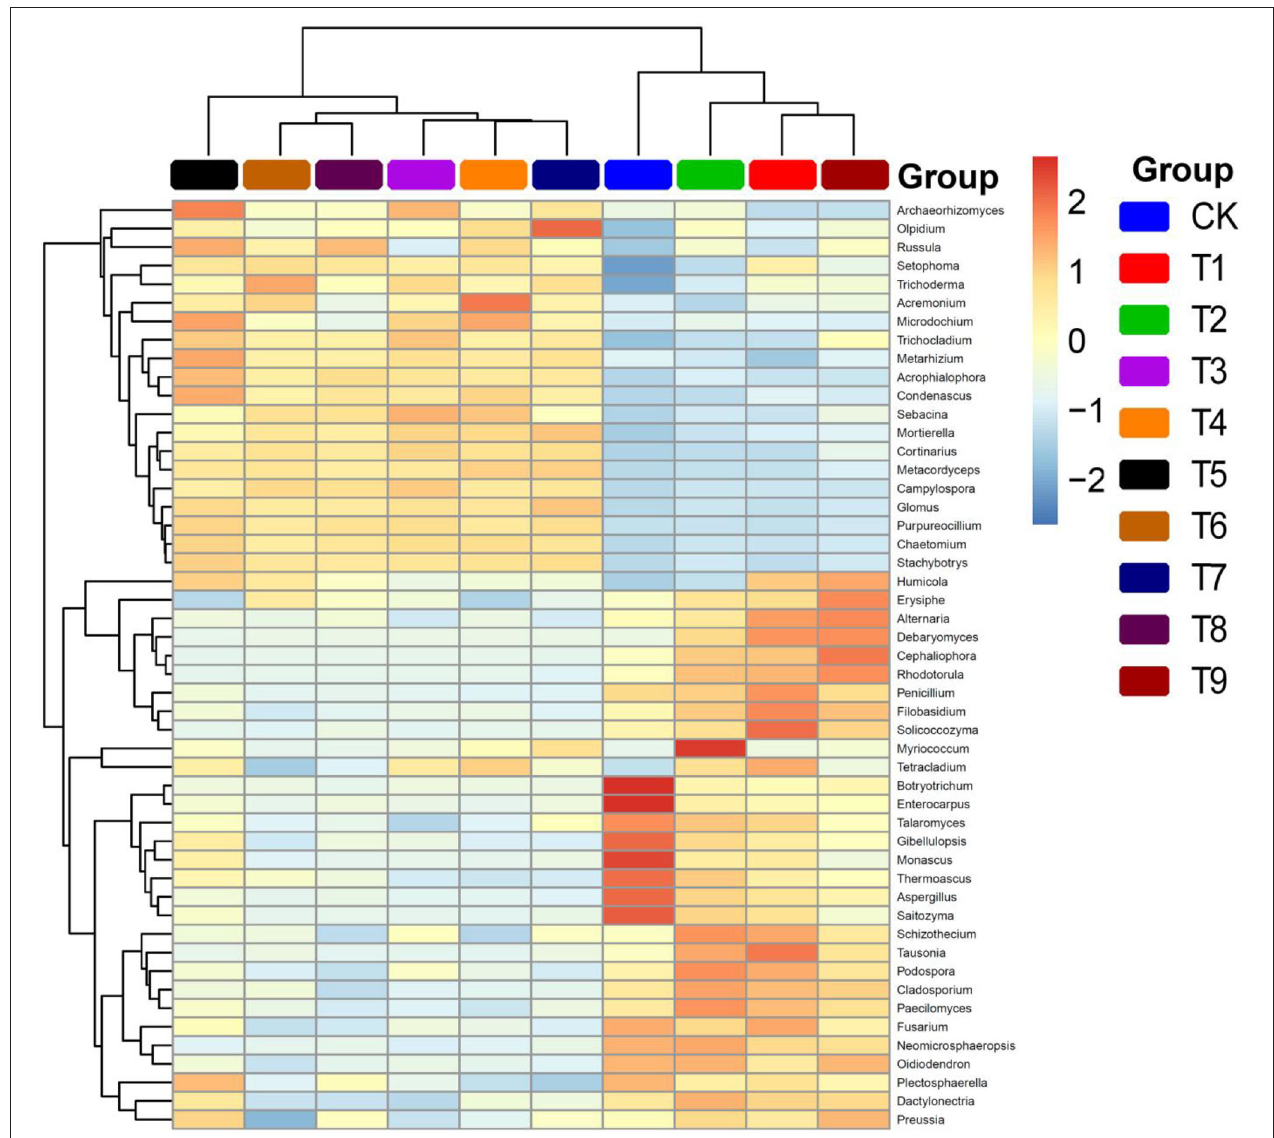
FIGURE 6 | Heat map of relative abundances of genera in ginseng rhizosphere fungal communities in different NPK fertilizer treatments. Note: (a) Composition of fertilization treatments: CK, N 0 P 0 K 0 ; T1, N 1 P 1 K 1 ; T2, N 1 P 2 K 2 ; T3, N 1 P 3 K 3 ; T4, N 2 P 1 K 2 ; T5, N 2 P 2 K 3 ; T6, N 2 P 3 K 1 ; T7, N 3 P 1 K 3 ; T8, N 3 P 2 K 1 ; T9, N 3 P 3 K 2